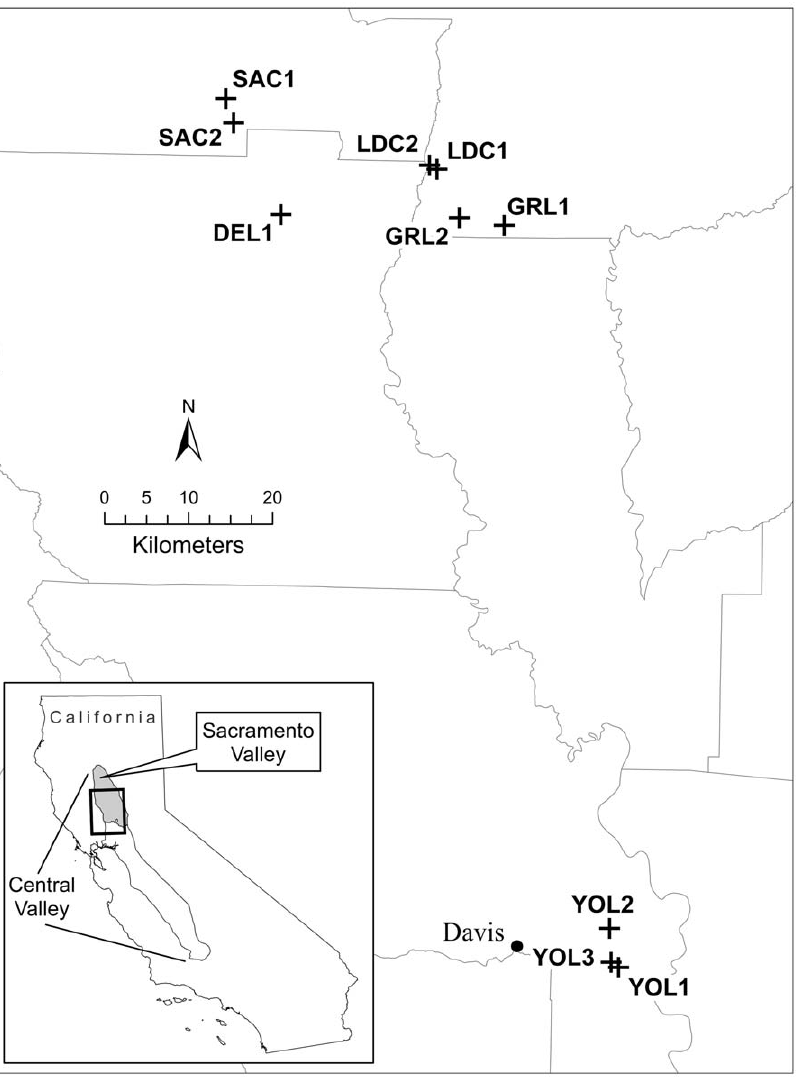
Figure 1. Location of the study wetlands. Water and fecal samples were collected during three periods across summer at all wetlands.